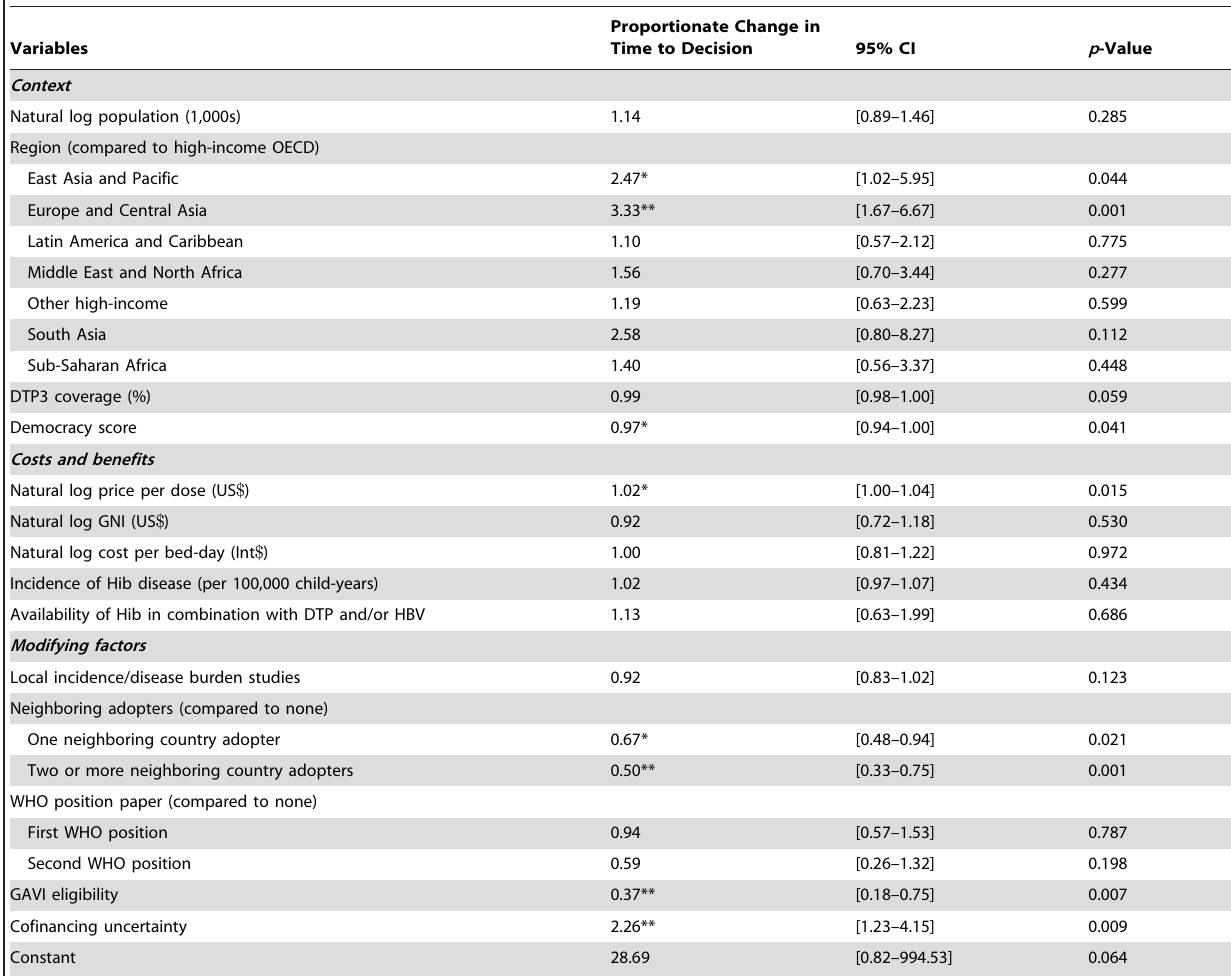
Table 3. Results from accelerated failure time